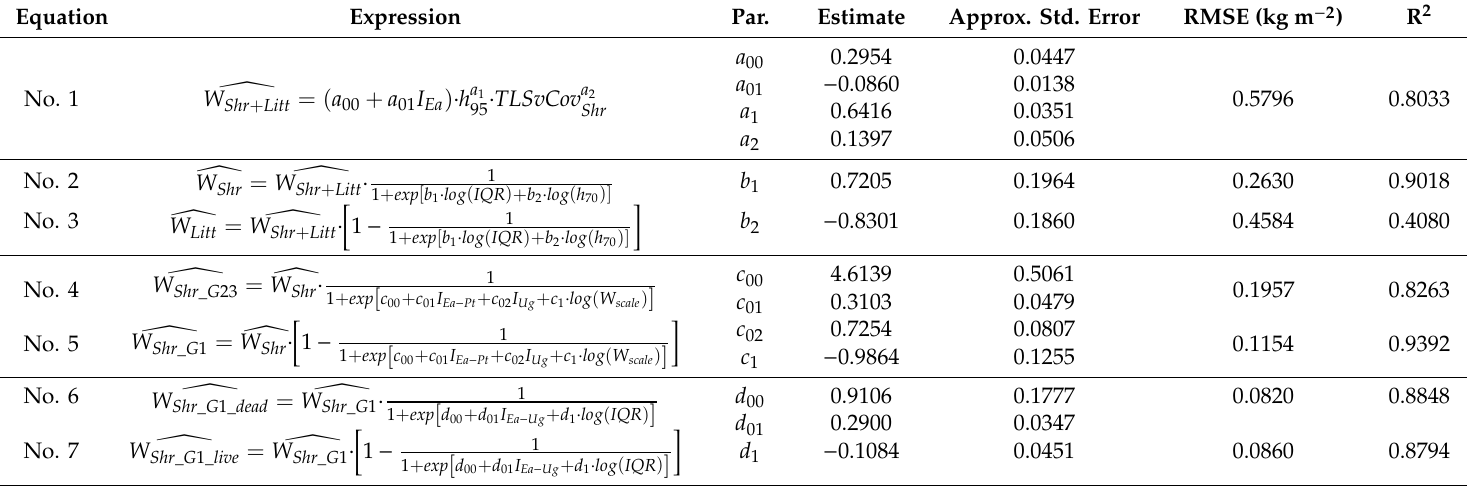
Table 4. Final expression of the system of equations fitted simultaneously to estimate fuel loads of each fraction, including the best set of independent variables, the parameter estimates, the approximate standard errors and the goodness-of-fit statistics. W Shr + Litt = shrub and litter fuel load, W Shr = total shrub fuel load, W Litt = litter fuel load, W Shr_G 23 = coarse shrub fuel load, W Shr_G 1 = fine shrub fuel load, W Shr_G 1_ dead = dead fine shrub fuel load, and W Shr_G 1_ live = live fine shrub fuel